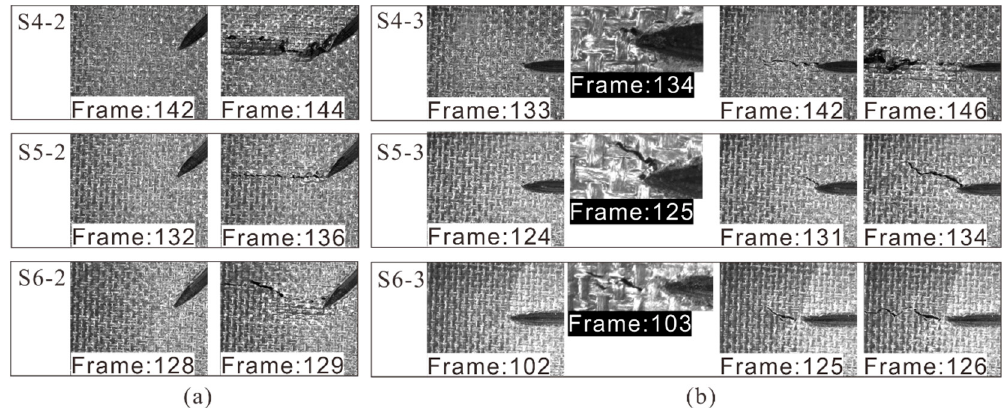
Figure 12. ( a ) 45 ◦ and ( b ) 90 ◦ medium cracks propagation under compression. When the crack depth increased to 60% of the thickness, local deformation zones appeared in the 45 ◦ crack tip in compression (see Figure 13a), forming the local damage zone. These local zones were caused by large shear stress concentration at the crack tip due to the angle between the load and the crack being 45 ◦ . With the increase of the load, the zone expanded and triggered the crack tip propagation. It should be noted that these cracks grew more slowly than the previously mentioned 45 ◦ cracks, the reason being that the damage zone reduced the stress concentration at the crack tip [36]. It is more